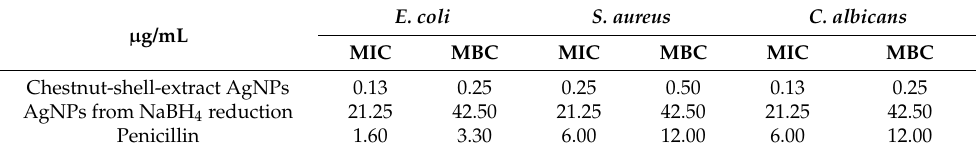
Table 1. The MIC and MBC of functionalized chestnut-shell-extract AgNPs and control samples. E. coli S. aureus C. albicans µ g/mL Chestnut-shell-extract